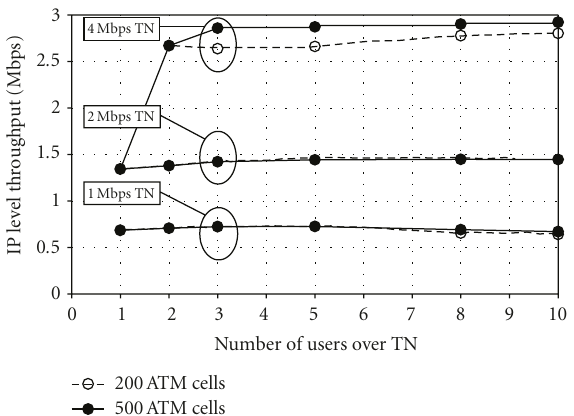
Figure 7: Average IP level throughput for di ff erent TN